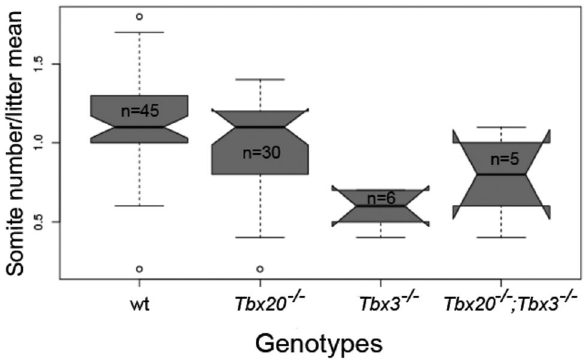
Figure 2. Tbx20 -/- ; Tbx3 -/- double homozygotes are developmentally delayed as are Tbx3 -/- embryos. Notched box plots showing the distributions of the ratio of somite number in an embryo / the mean somite number for the litter in four different groups: wild type, Tbx20 -/- homozygous mutants ; Tbx3 -/- homozygous mutants and double homozygotes. Compound and single mutants were combined for this comparison as single mutants were not different from the compounds (Mann Whitney U test). Whiskers of the notched box plots represent 10th and 90th percentiles, boxes include the 25th through 75th percentile, and outliers are individually plotted. If the notches of two plots do not overlap, this indicates that the medians differ between the two. With respect to developmental stage, Tbx20 -/- ; Tbx3 -/- double homozygotes resemble Tbx3 -/- embryos and both groups are delayed compared to wild type or Tbx20 -/-